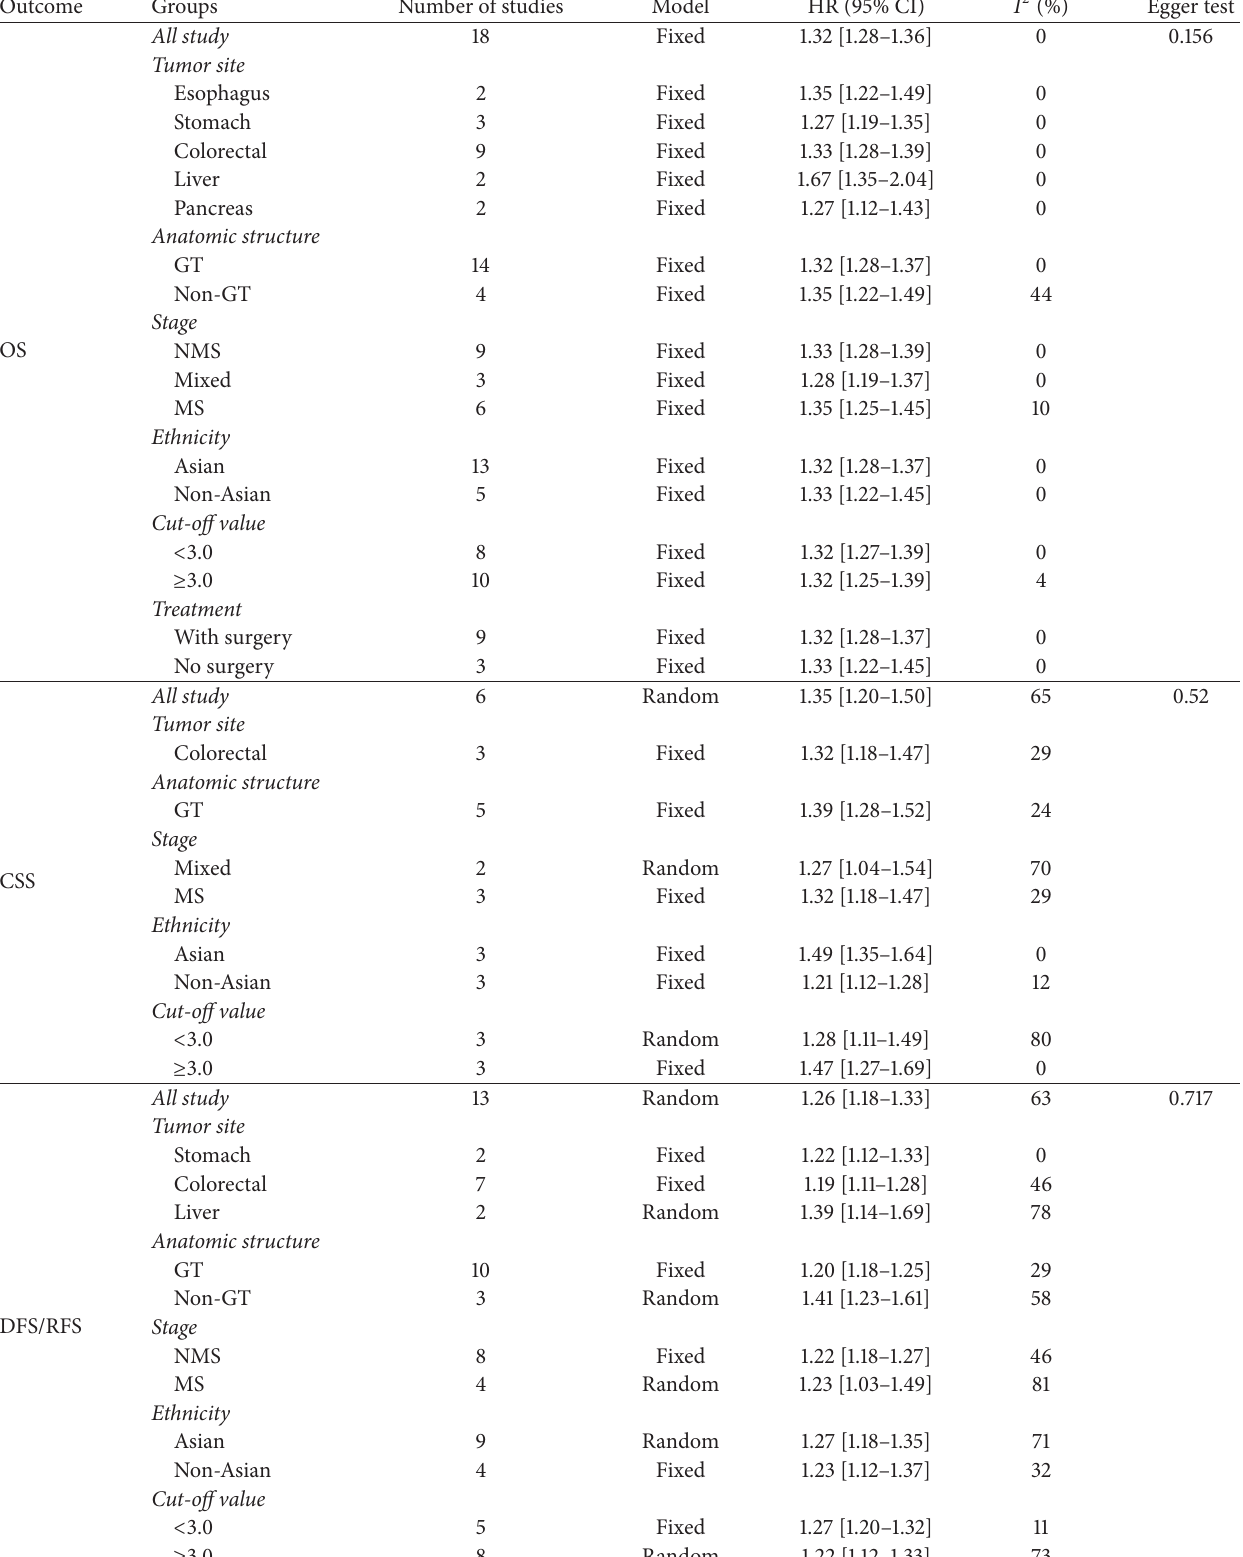
Table 2: Meta-analysis of HRs from univariate survival